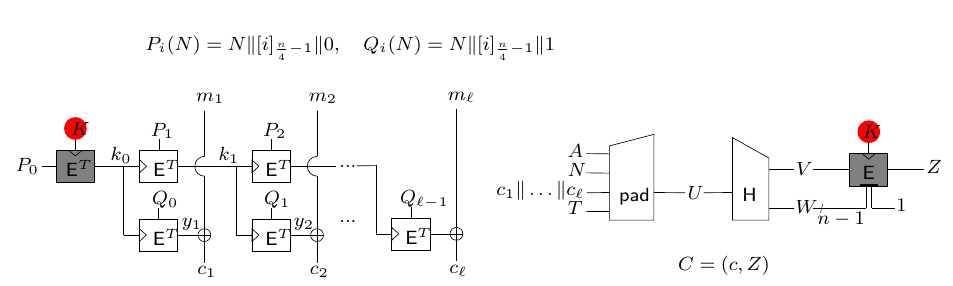
Figure 4: The TEDT AEAD. The constants P i and Q i are derived from the nonce N , i.e., P i = N k [ i ] n k 0, and Q i = N k [ i ] n k 1, where i ∈ [0 , . . . , 2 n 4 − 1 − 1]. The two dark blocks are 4 − 1 4 − 1